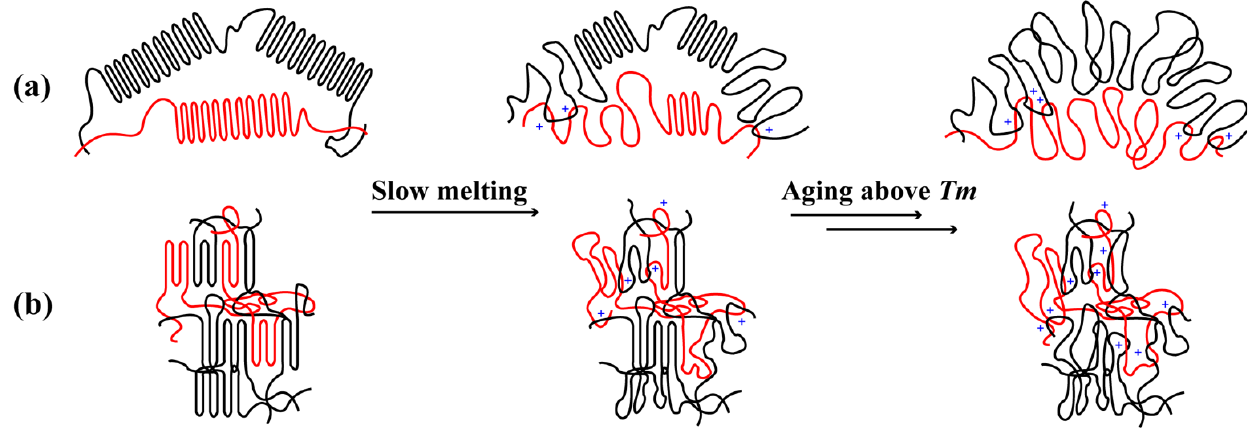
Figure 8. Schematic transformation of PE morphologies: ( a ) less-entangled UHMWPE and ( b ) well- entangled UHMWPE during slow melting. The left column shows the initial morphology of PE from freeze-extracting. The middle column shows the state of PE in slow melting, and the right column shows their melting states completely. The red line represents the observed chain, the black line represents its neighbors, and the blue cross represents the new entanglement during slow melting.